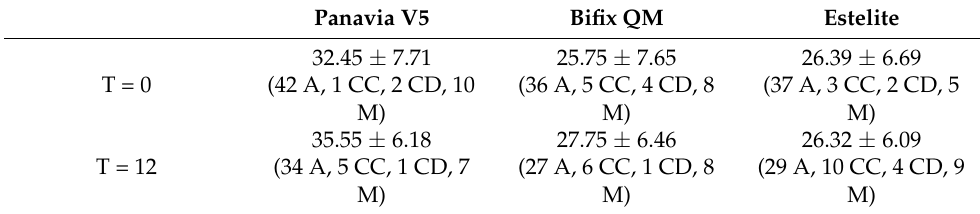
Table 2. Microtensile bond strengths (mean ± SD, in MPa) of group 1 (V5), group 2 (QM), group 3 (ES), immediately after bonding (T0) and after 1 year of ageing (T12) in artificial saliva. Number of the failures are reported in parentheses and classified as adhesive (A), cohesive in dentin (CD), cohesive in cement (CC), or mixed (M)